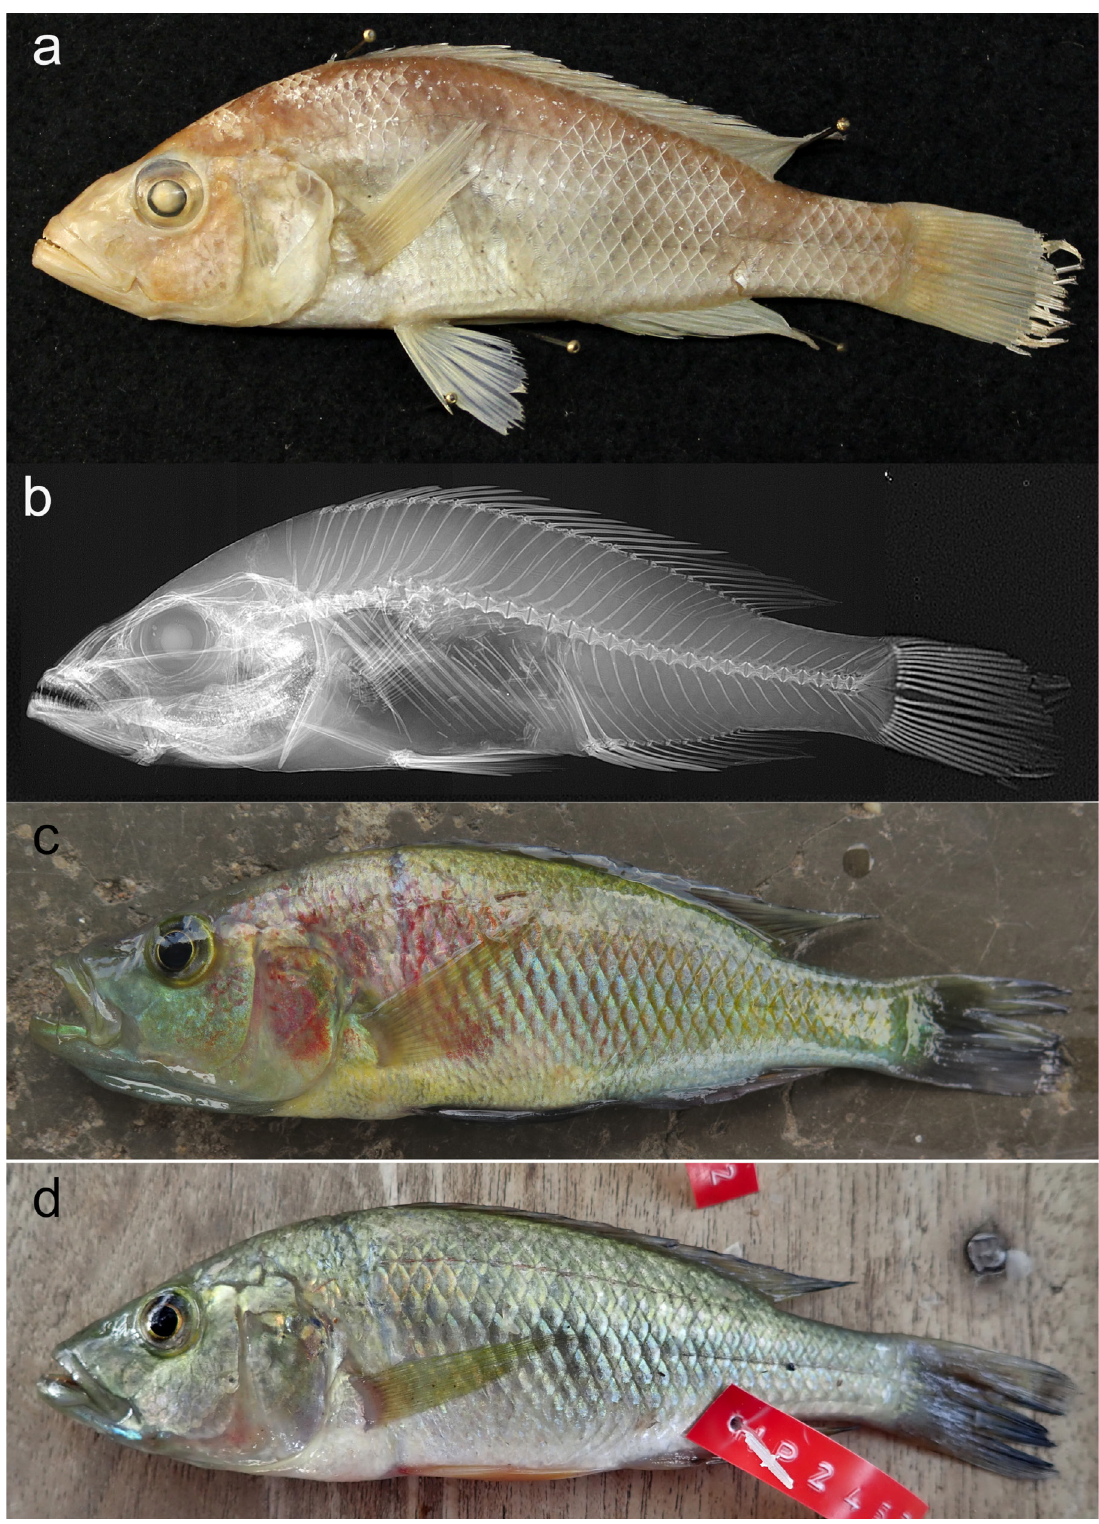
Fig. 9. Haplochromis mentatus Regan, 1925. a . Photograph of preserved holotype (MCZ 31523; 93.1 mm SL). b . X-ray image of holotype. c – d . Photographs of freshly caught specimens. c . Dominant male (RMCA 2017.006.P.0424; 107.9 mm SL). d . Female (RMCA 2018.008.P(HP2453); 116.2 mm SL) to illustrate the live colour patterns. The contrast was slightly